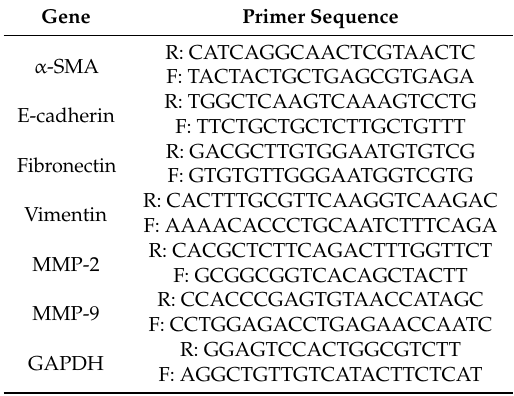
Table 1. List of real-time qPCR primers used in this